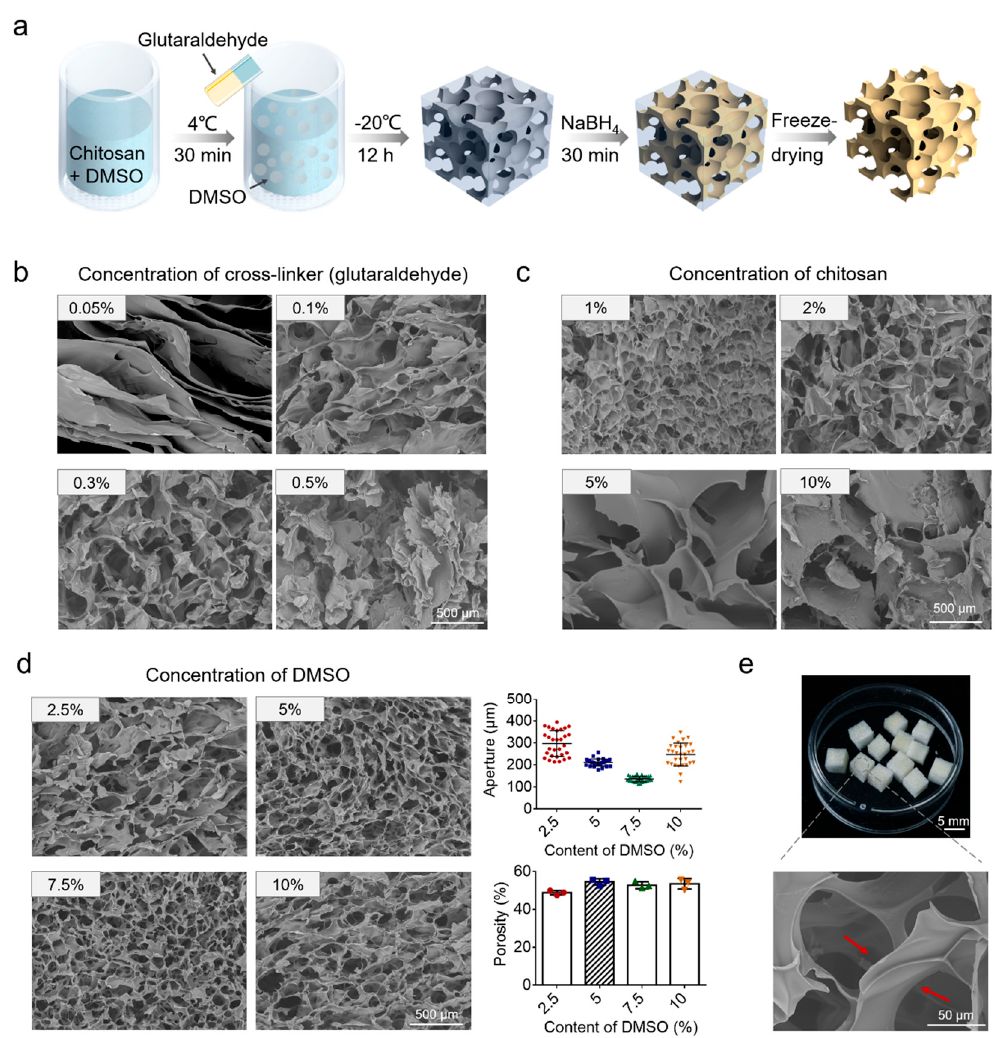
Figure 3. Optimization of the chitosan scaffold. ( a ) A general workflow was developed for the fabrication of the chitosan scaffold. ( b ) SEM images of chitosan scaffold fabricated with different concentrations of cross-linker glutaraldehyde. The concentration of chitosan was fixed at 2%. ( c ) SEM images of chitosan scaffold fabricated with different concentrations of chitosan. The concentration of glutaraldehyde was fixed at 0.3%. ( d ) SEM images, aperture, and porosity of chitosan scaffold fabricated with different concentrations of DMSO. The concentration of glutaraldehyde and the concentration of chitosan were fixed at 0.3% and 2%, respectively. ( e ) Photo and enlarged view of the optimized chitosan scaffold. Red arrows indicate the pores in the chitosan scaffold are connected to each other.